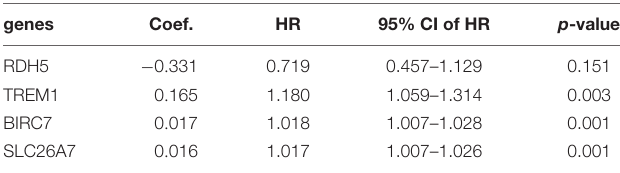
TABLE 2 | Coefficients based on a multivariate Cox regression analysis of four genes. genes Coef.